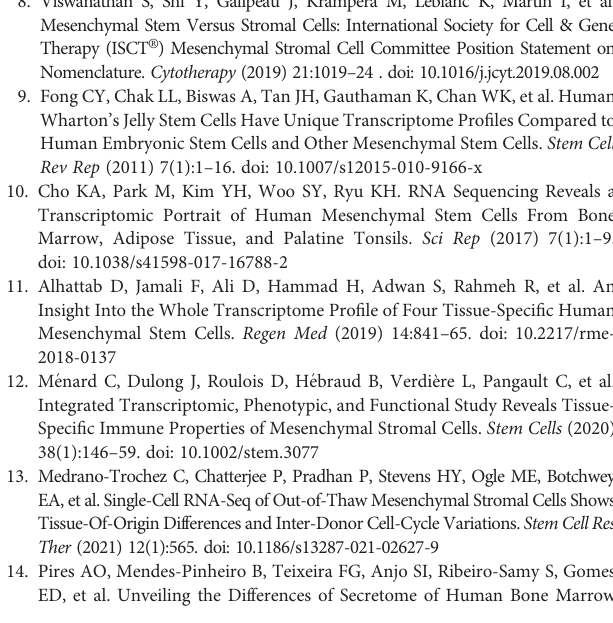
Supplementary Figure 1 | (A) Primer sequences used in RT-qPCR for 3 reference genes and 5 genes of interest. (B) Relative expression of genes of interest found by RT-qPCR, displayed as mean ± SEM of 3 donors, con fi rms their microarray expression. BM, bone marrow; F, forward; MSCs, mesenchymal stromal cells; R, reverse; ref, reference gene; UC, umbilical cord. Supplementary Figure 2 | (A) UC and BM-MSC donor populations exhibit different doubling kinetics during the activation and CM collection period. Secreted analyte concentration was normalized to cell number at harvest and analyzed using units of pg/ml/million cells. (B) Dosed cytokines were not detected in UM after the 24-hour activation period. (C) SubstantialMSC donor variability in secretion of TGF- b 2 and IL-17 precluded statistical analysis. BM, bone marrow; CM, conditioned media; MSC, mesenchymal stromal cell; UC, umbilical cord; UM, unconditioned media. Supplementary Figure 3 | Correlation between transcriptome and secreted responses of resting and activated UC (orange) and BM-MSCs (blue). (A) A modest relationship exists between transcriptome expression and secreted protein concentration in CM from resting MSCs. When MSCs are primed with (B) TNF- a